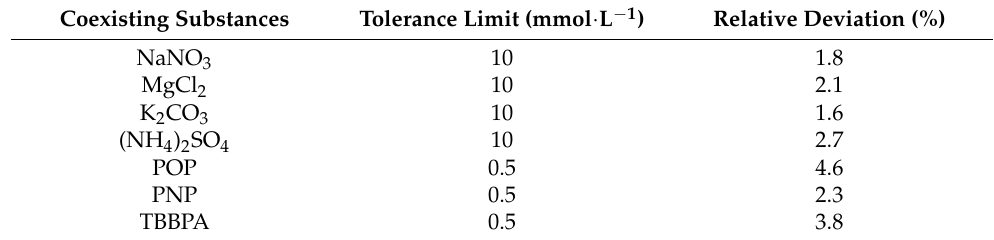
Table 2. Maximum tolerable concentration of coexisting substances with 0.1 mmol · L − 1 BPA.